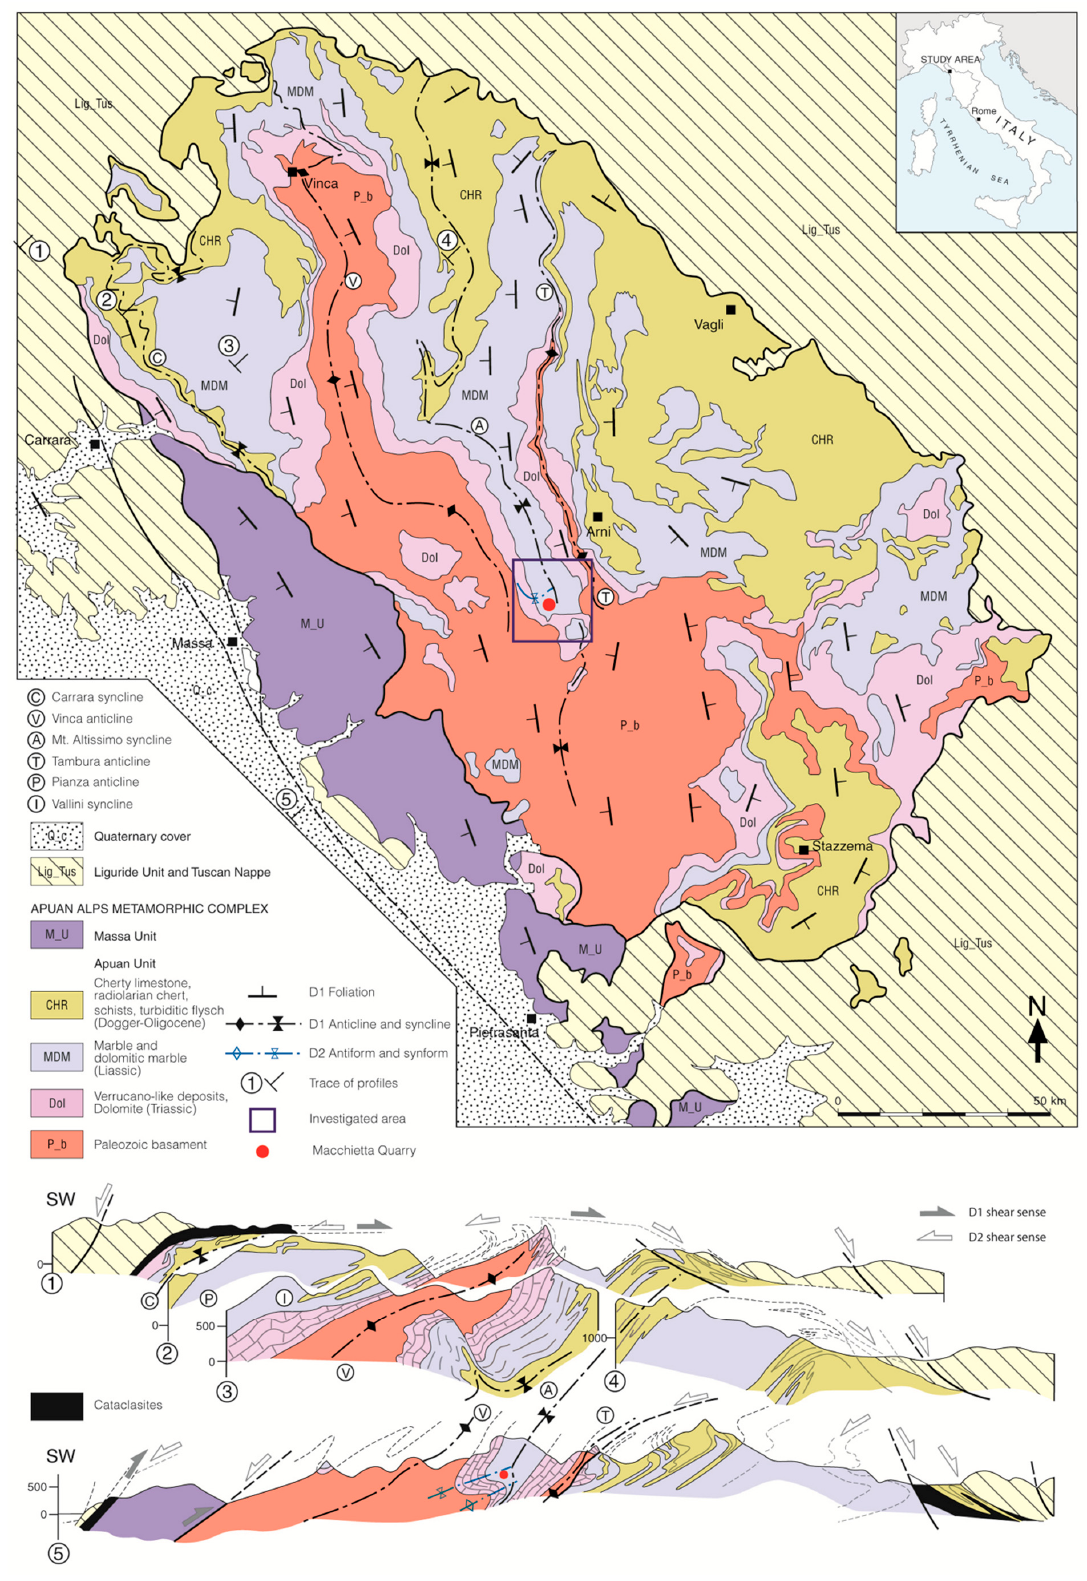
Figure 2. Simplified geological map of the Apuan Alps; the investigated area is highlighted with a rectangle and the location of the quarry is indicated by a point (modified after [25]).